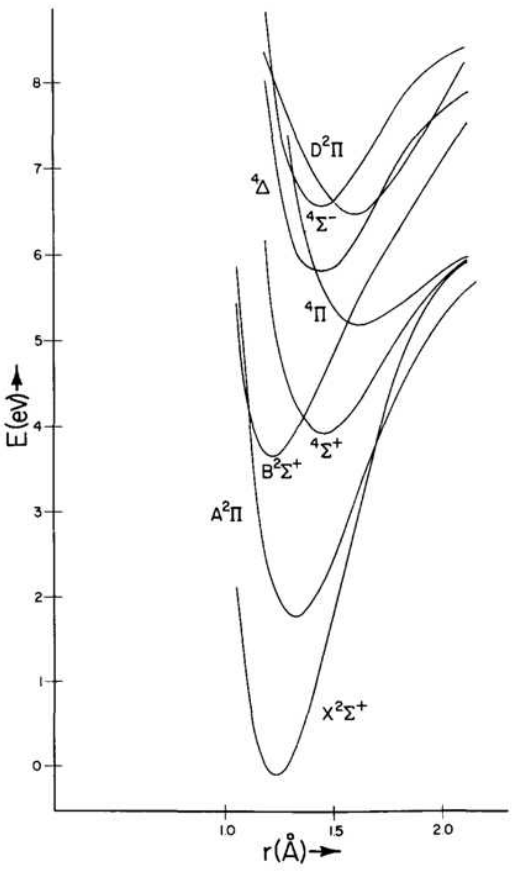
Figure 21. Potential curves [166] for selected low-energy levels of CN.